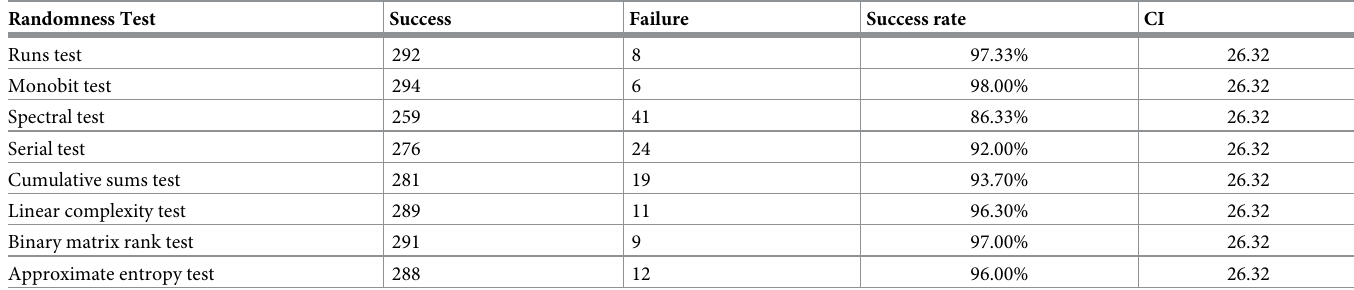
Table 4. Key avalanche test.